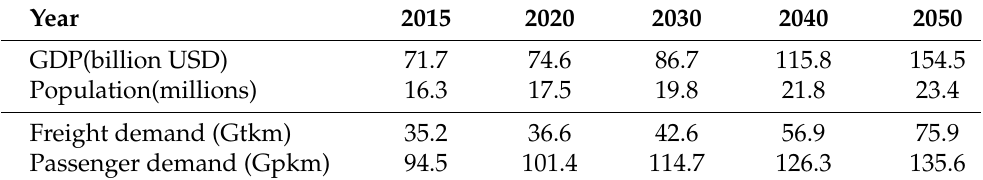
Table 5. Passenger and freight transport demand and